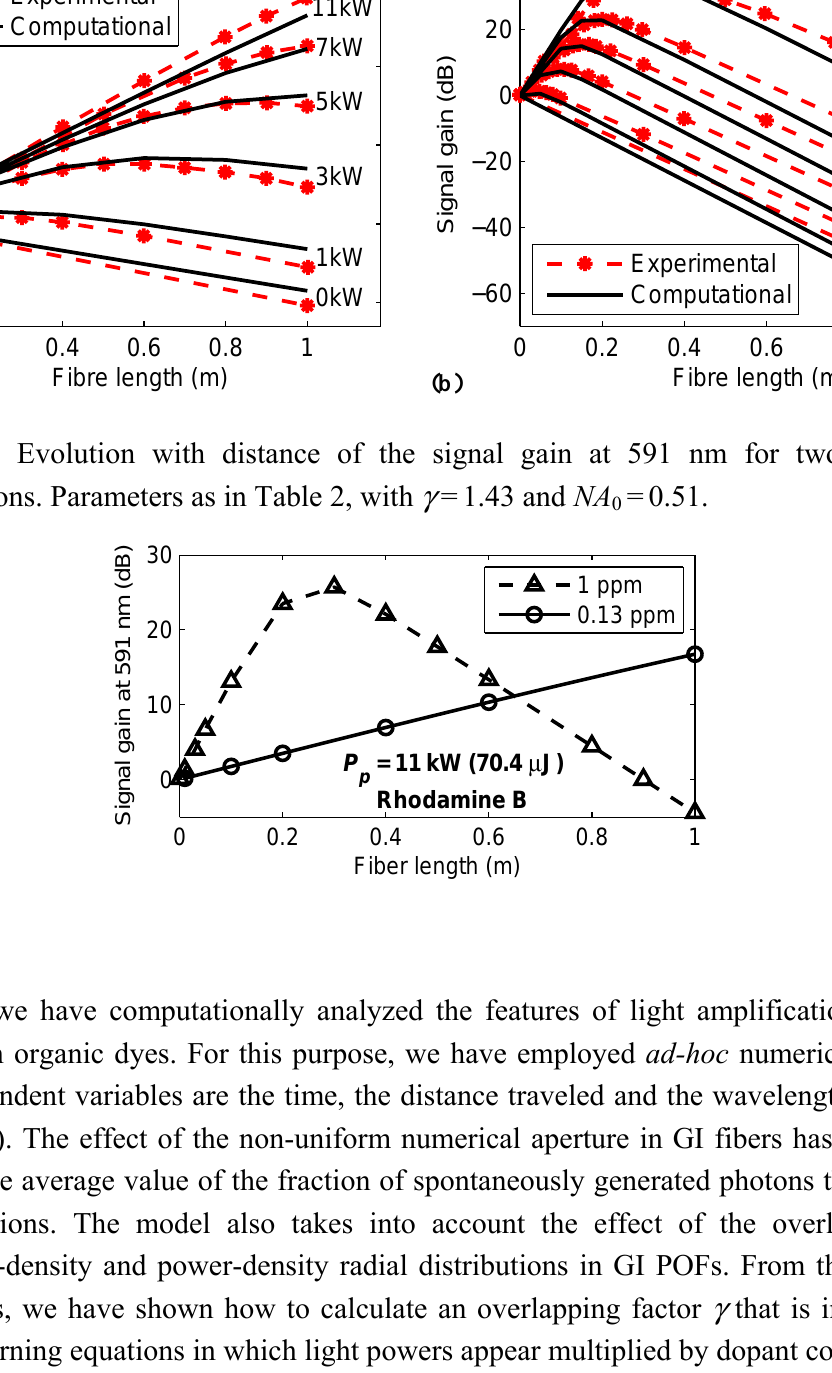
Figure 11. Signal gain as a function of length for GI fibers with average dye densities of ( a ) 0.13 ppm and ( b ) 1 ppm. Parameters as in Table 2, with γ = 1.43 and NA experimental results have been taken from [12].